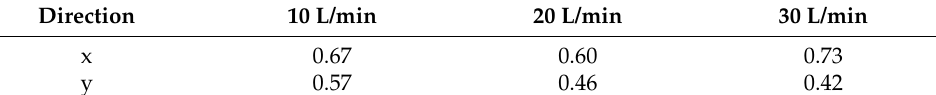
Table 1. Correlation coefficient in different working condition.